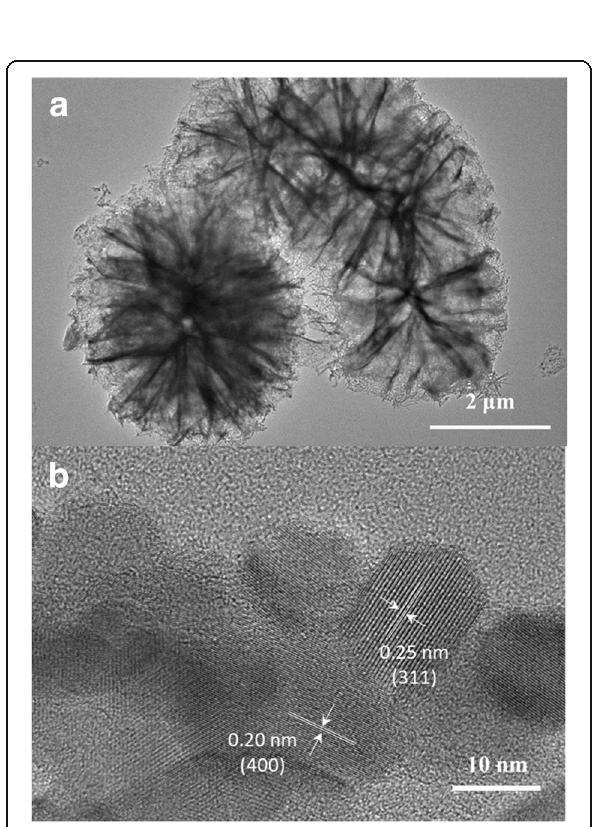
Fig. 4 a , b TEM images of the sea urchin-like NiCo 2 O 4 synthesized with 5 g PDDA